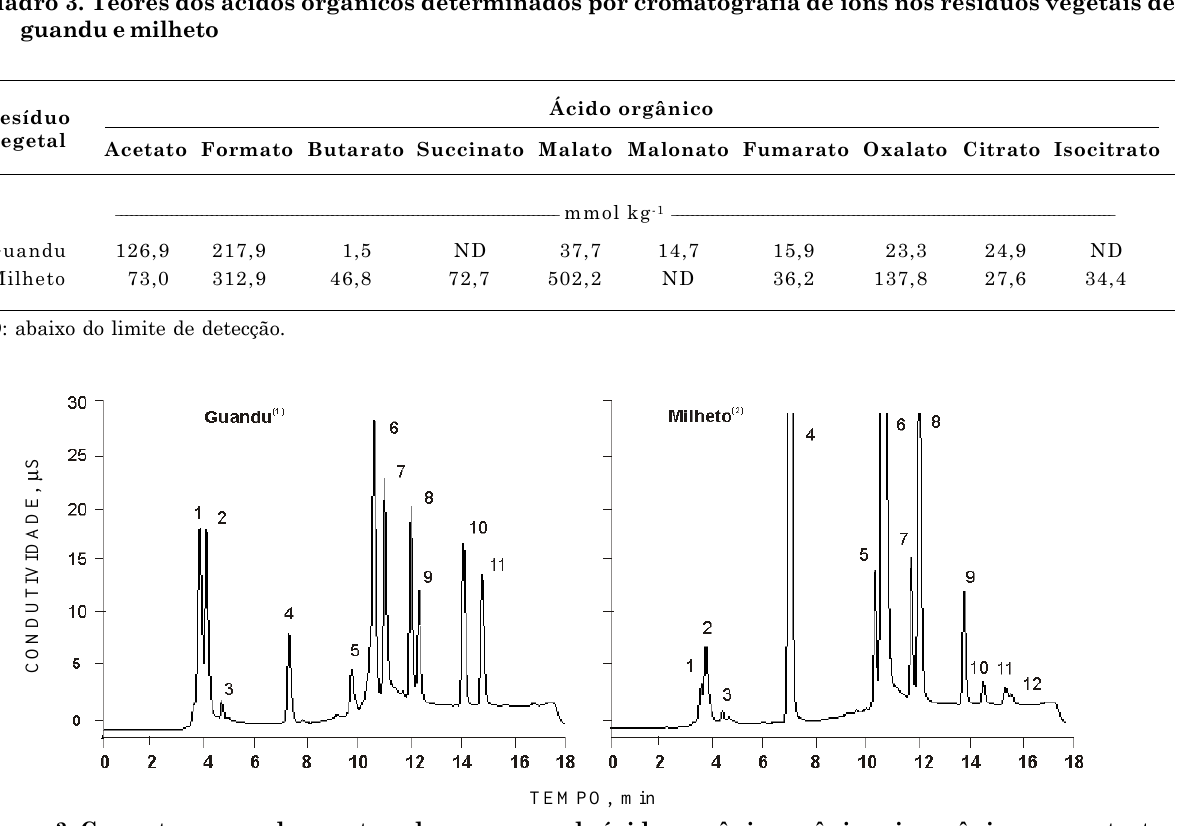
complexos organometálicos. A liberação de ácidos orgânicos do tecido vegetal (Figura 4) favorece a formação desses complexos com os íons metálicos do